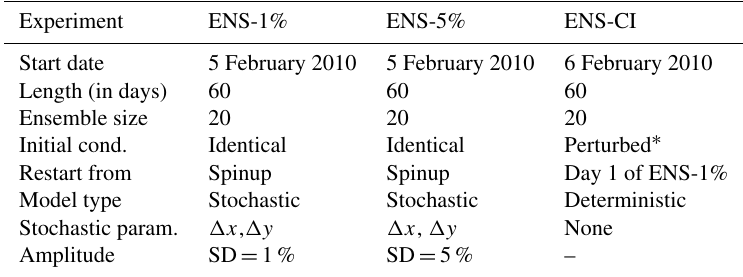
Table 2. Characteristics of the three ensemble forecast experiments ENS-1%, ENS-5%,